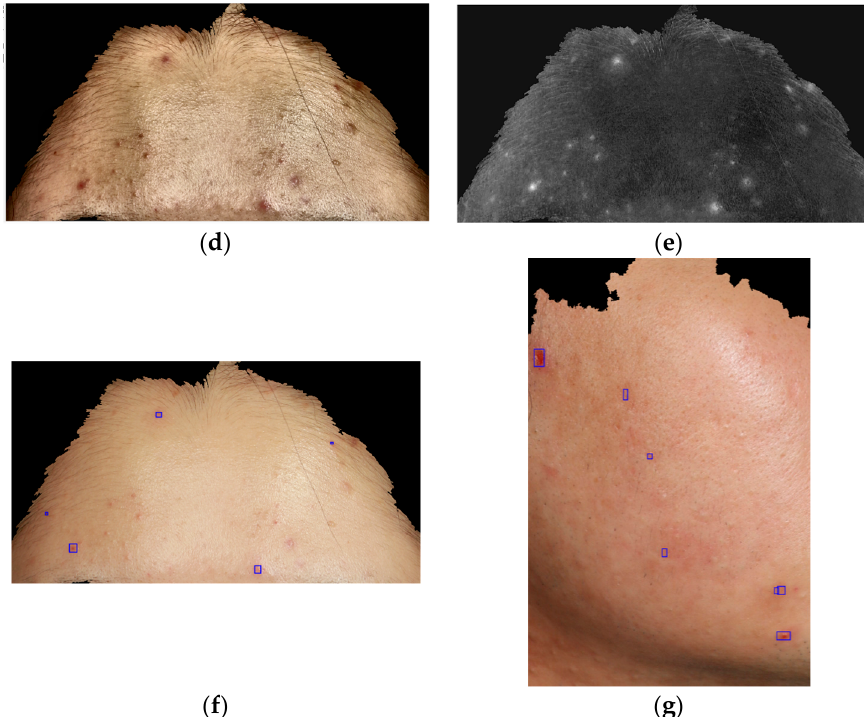
Figure 2. Evaluation of the number of lesions exceeding the erythema threshold (NET) and summation of the area exceeding the erythema threshold (Pixel %) using a skin color analysis system. ( a ) SpyderCUBE ® and SpyderChkecker ® for correction of white balance, exposure color, and black and white values. ( b ) Facial region extraction with the Viola–Jones algorithm before ( c ) and after ( d ) converting into a CIELAB image. ( e ) A* channel images. ( f , g ) Area higher than the threshold-specific erythema value from A* channel images to evaluate the number of lesions exceeding the erythema threshold (NET) and the summation of the area exceeding the erythema threshold (pixel %).